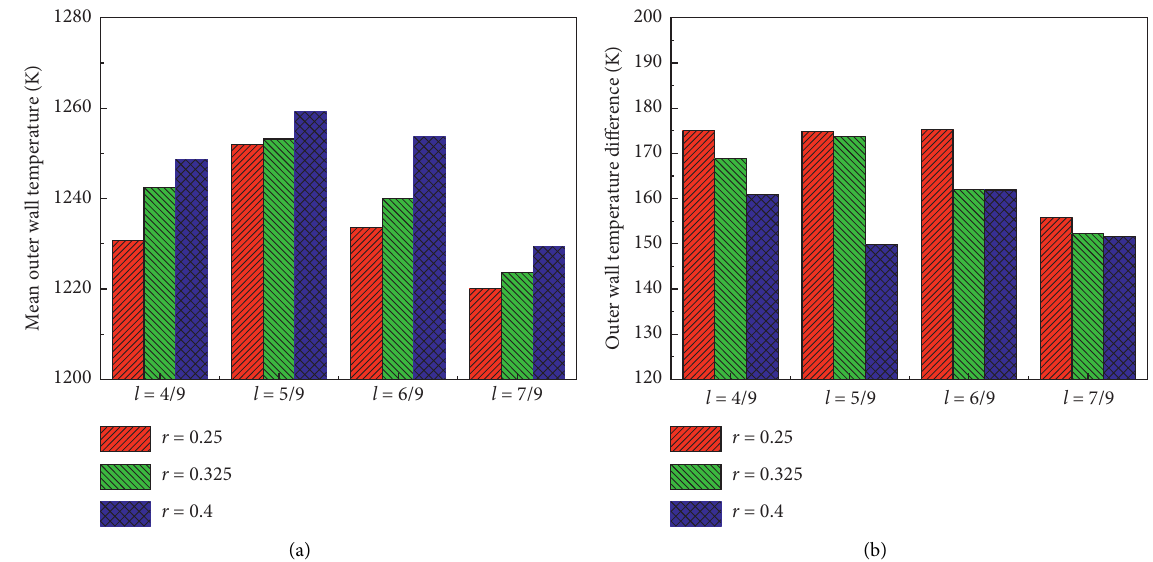
Figure 9: Mean outer wall temperature and outer wall temperature at different l and r